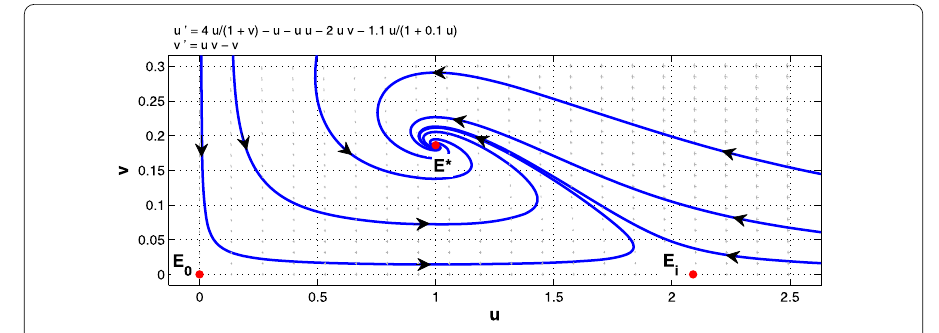
Figure 8 Dynamic behavior of system (5.2) with r 0 = 4, d = 1, k = a = m = 1, c = 0.5, p = 2, E = 1, m 1 = 1, m 2 = 0.1, and q = 1.1